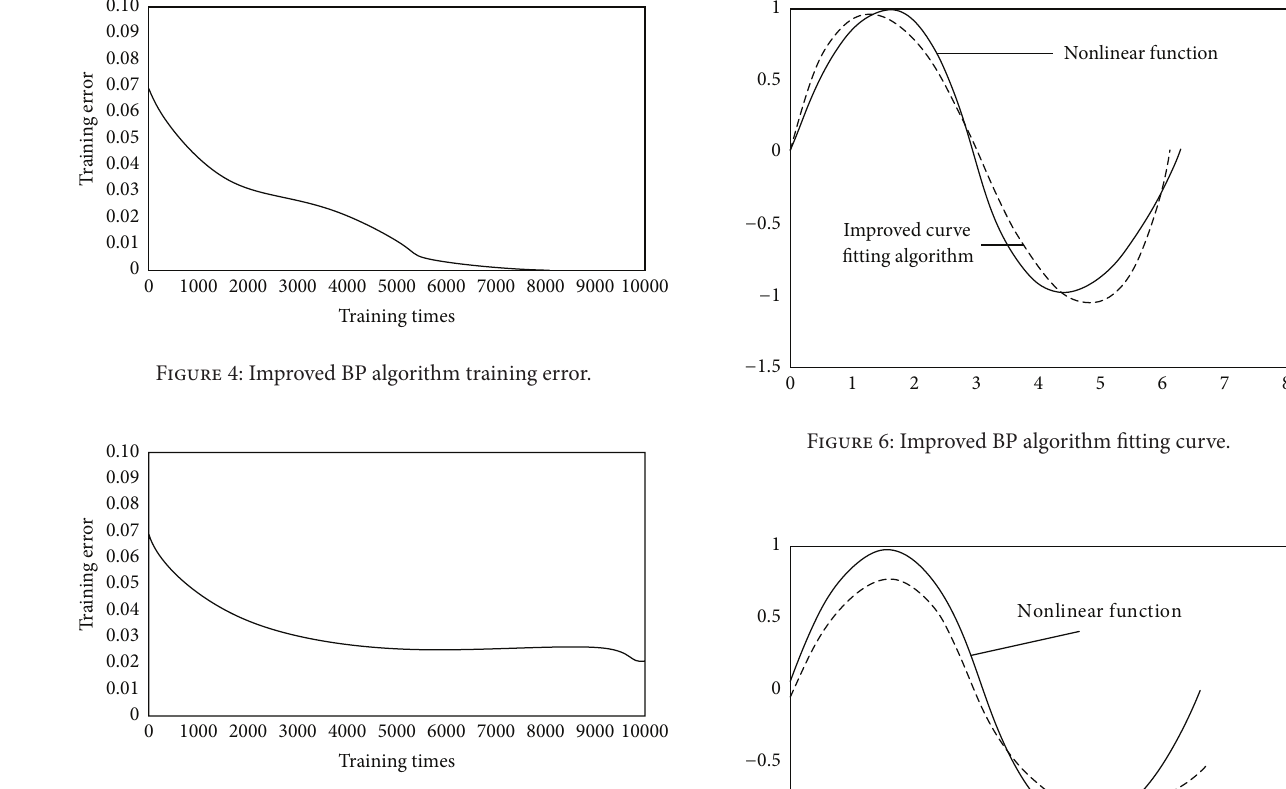
Figure 5: Traditional BP algorithm training error.